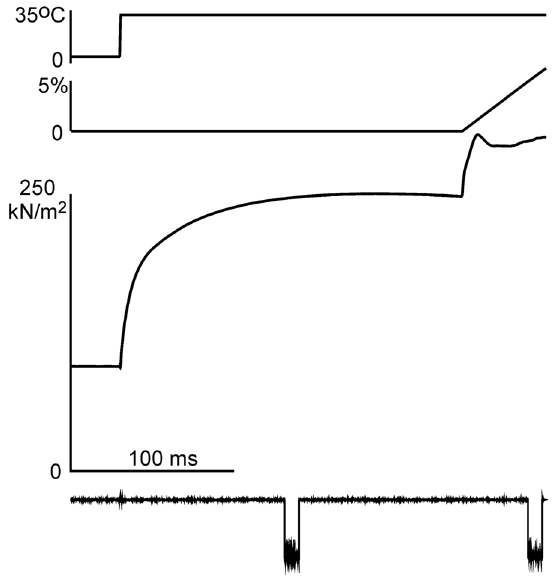
Figure 1. Experimental protocol. Averaged records (from top to bottom): calculated temperature, motor position (in % of bundle length), tension and an example of the x-ray exposure framing (signal from a pin diode in a run of the experimental protocol). Noise on the pin diode signal, 30 ms from the beginning of the recording is caused by the high voltage heating pulse of the T-jump apparatus.